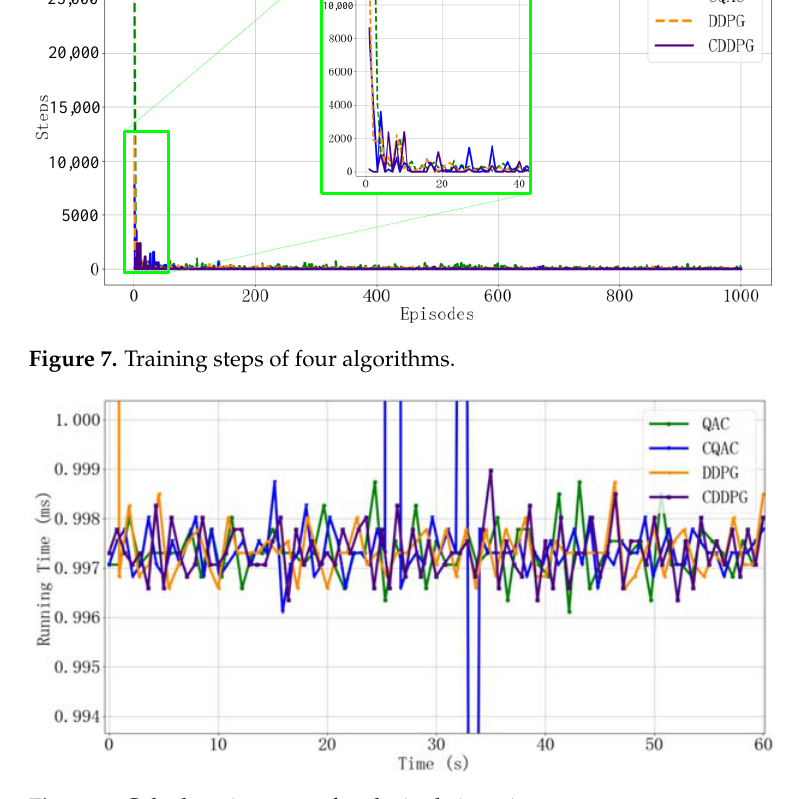
Figure 8. Calculate time cost of each single iteration step.